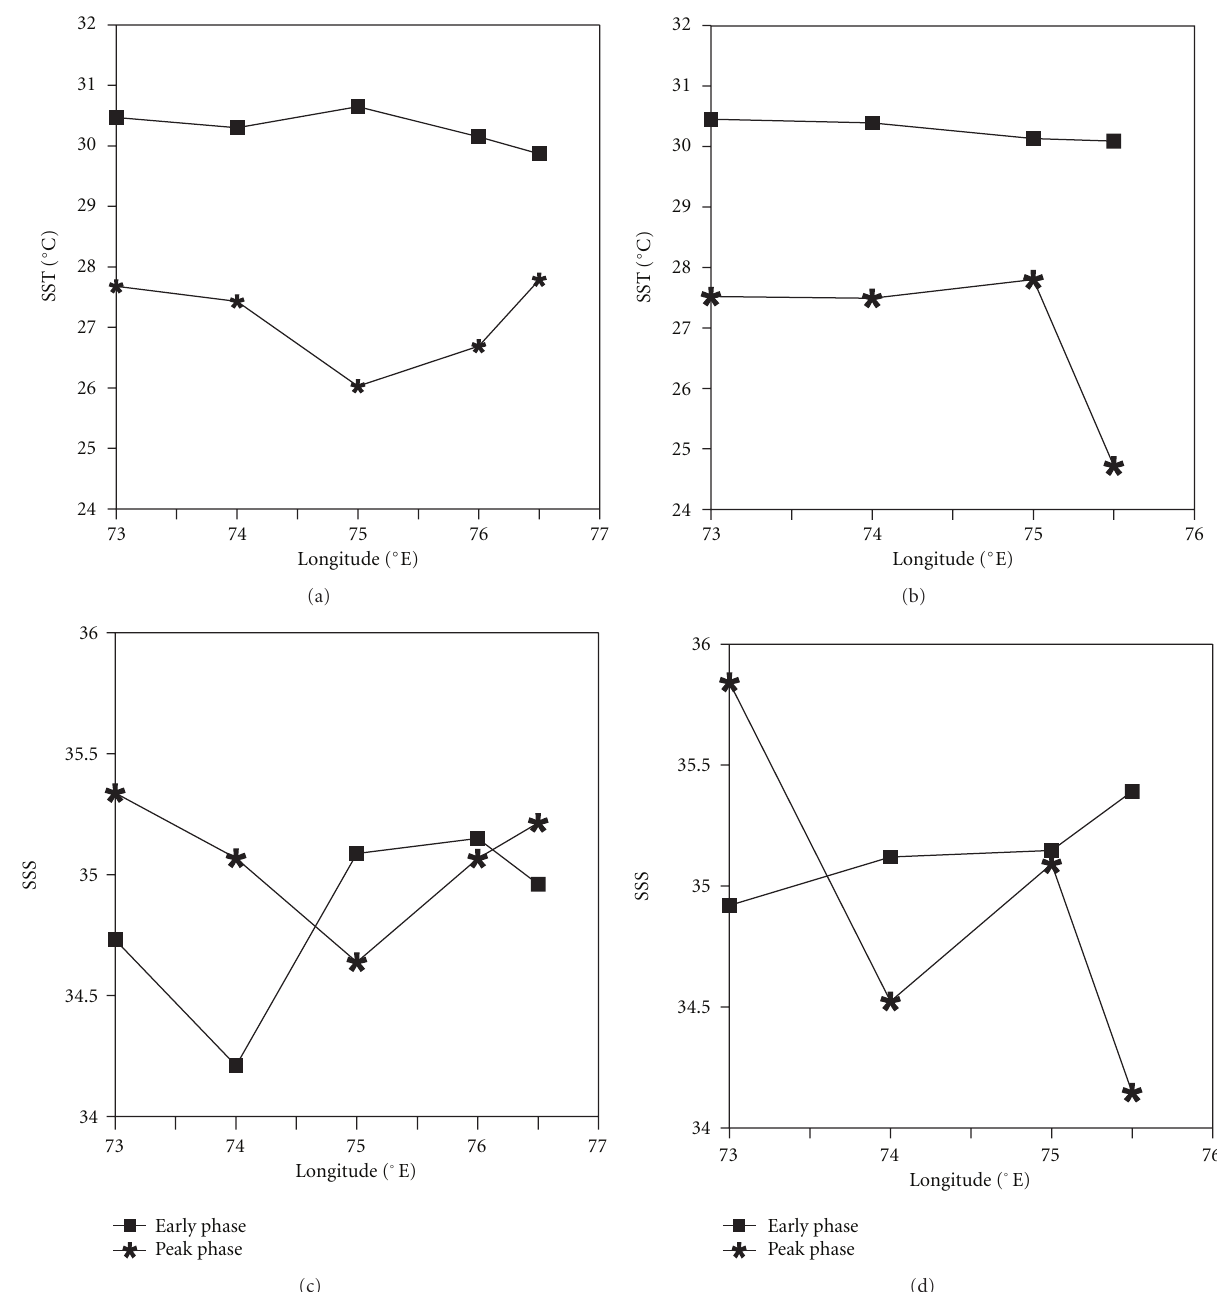
Figure 2: Distribution of sea surface temperature (SST, ◦ C; (a, b) and sea surface salinity (SSS; (c, d)) along 8 and 10 ◦ N during early and peak phases of summer